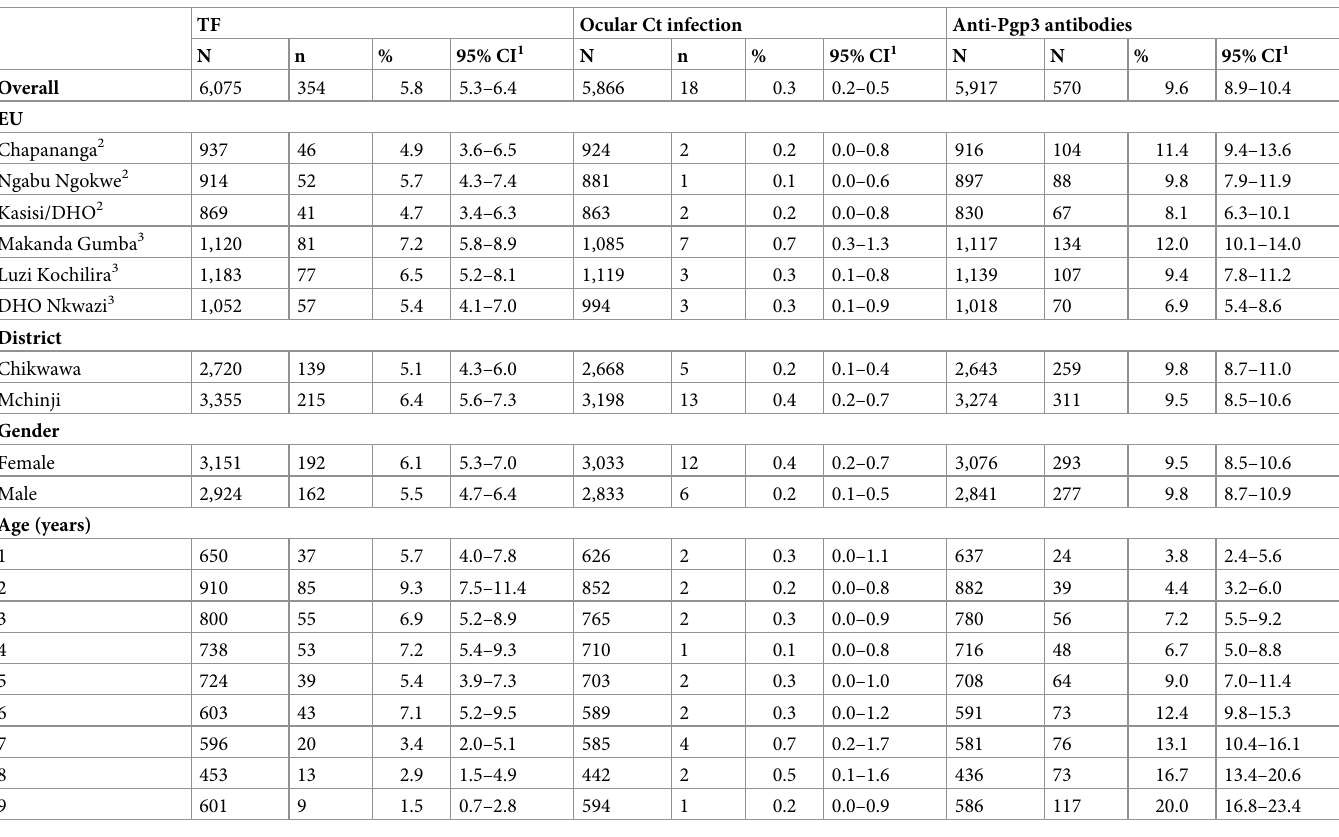
Table 2. Prevalence of trachomatous inflammation—follicular (TF), C . trachomatis infection and anti-Pgp3 antibodies in participants aged 1–9